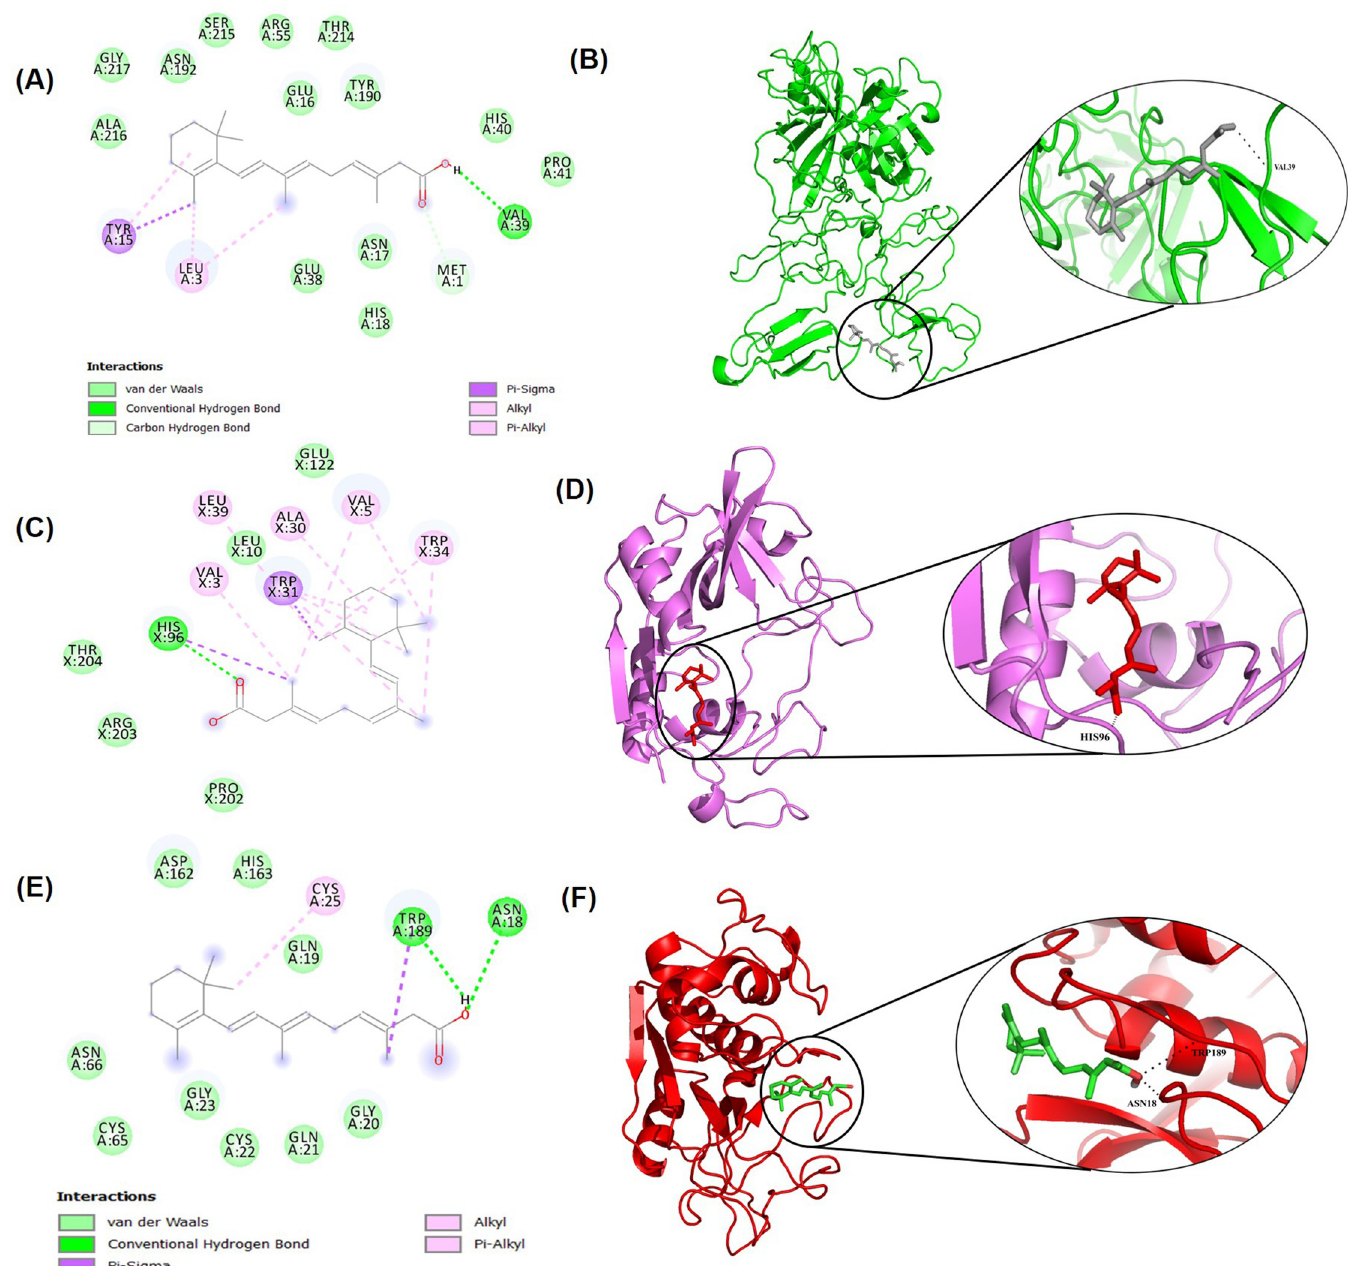
Fig 6. Molecular docking study of retinoic acid to TMPRSS2, CTSB, and CTSL. 2D diagrams of (A) TMPRSS2- retinoic acid, (C) CTSB-retinoic acid, and (E) CTSL- retinoic acid interactions from Ligplot+ analysis. The figure provides the information about the interactions and the protein residues and interactions are colored accordingly. The best docking poses in the 3D structure of the proteins are represented in (B), (D), and (F).